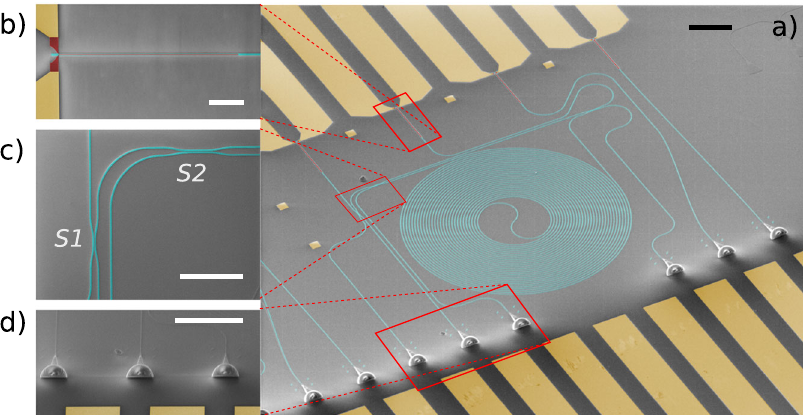
Fig. 2 SEM image of receiver chip. a Colorized scanning electron microscope (SEM) image of the receiver circuit, where the waveguide is cyan colored. Scale bar corresponds to 100 μ m. b One of the superconducting nanowire single-photon detectors (red) on top of the waveguide (cyan). Scale bar corresponds to 20 μ m. c The input splitter (S1) redirects ~10% of the incoming light into the MZI, where the length of splitter S2 is adjusted to account for waveguide losses in the spiral. Scale bar corresponds to 50 μ m. d The 3D couplers allow to vertically couple light over a broad wavelength range into the waveguide. Scale bar corresponds to 100 μ